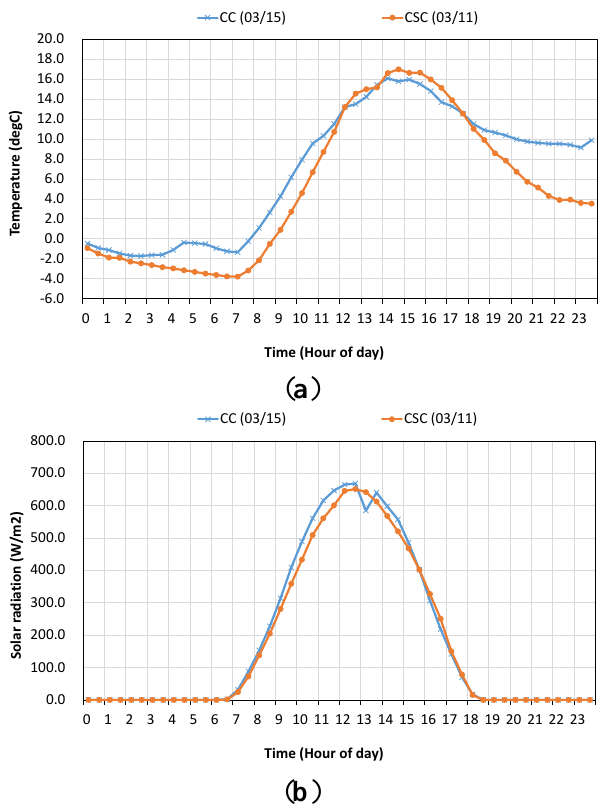
Figure 8. Comparison of weather conditions, ( a ) outdoor temperature and ( b ) global horizontal solar radiation, for two space-heating operation test days with CC and